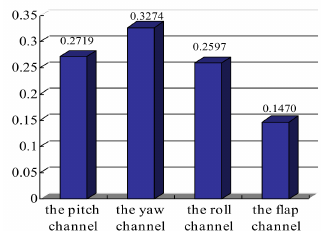
Figure 5. The weight of 4 channels.